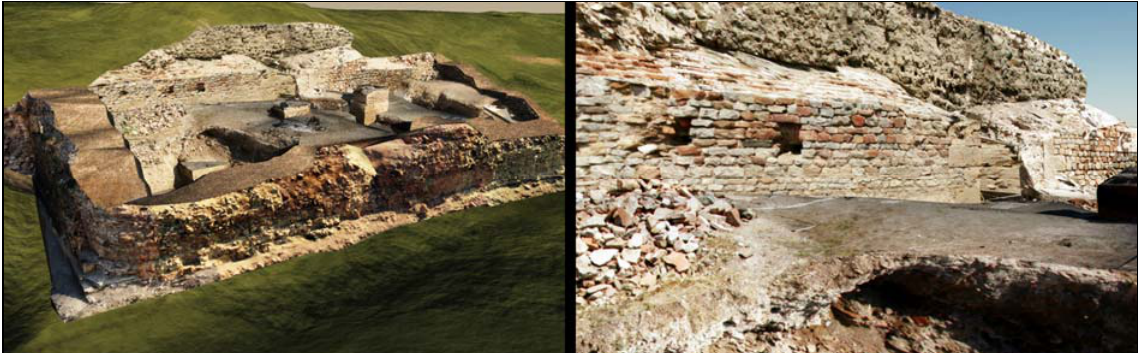
Figure 12. 3D model of the Large Tower rendered in Vue 7 xStream . Views from outside (left) and inside (right) the tower.